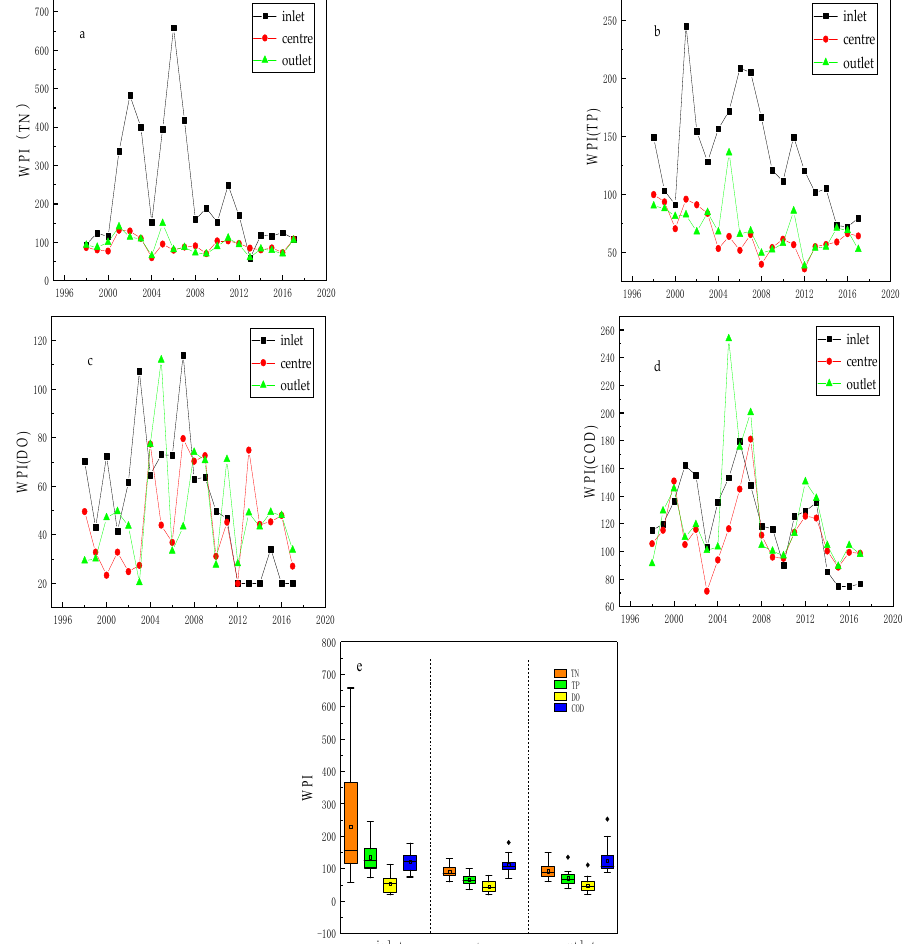
Figure 4. Concentrations of relevant water quality indicators and spatial variation in the WPI: ( a ) WPI TN ; ( b ) WPI TP ; ( c ) WPI DO ; ( d ) WPI COD ; ( e ) the box and whisker plots of spatial variation in Ulansuhai.